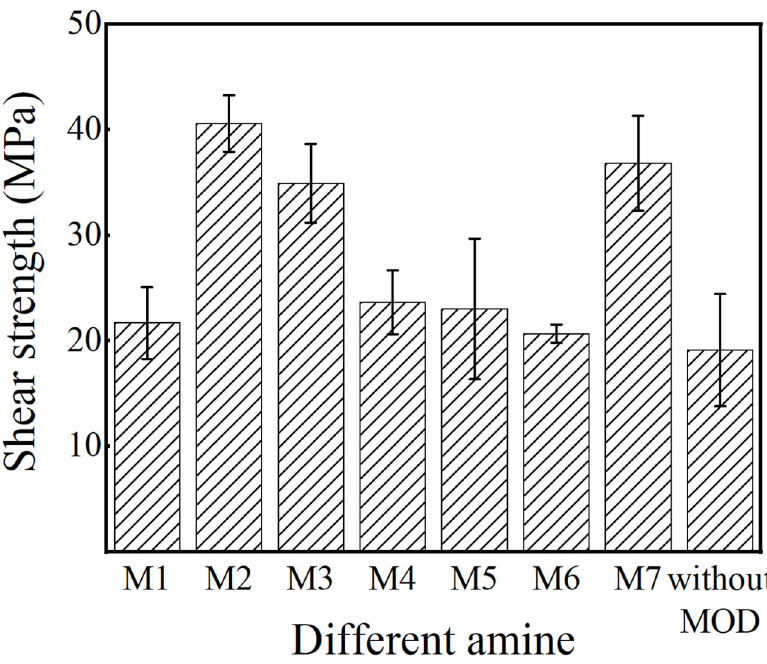
Figure 12. Shear strength of different Ag sintering joints: M1–M7 and pure Ag without MOD.